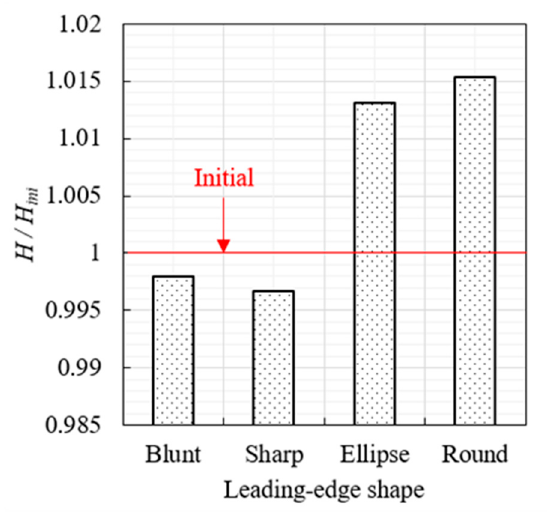
Figure 9. Comparison of the impeller head, H , against the initial impeller head, H ini .